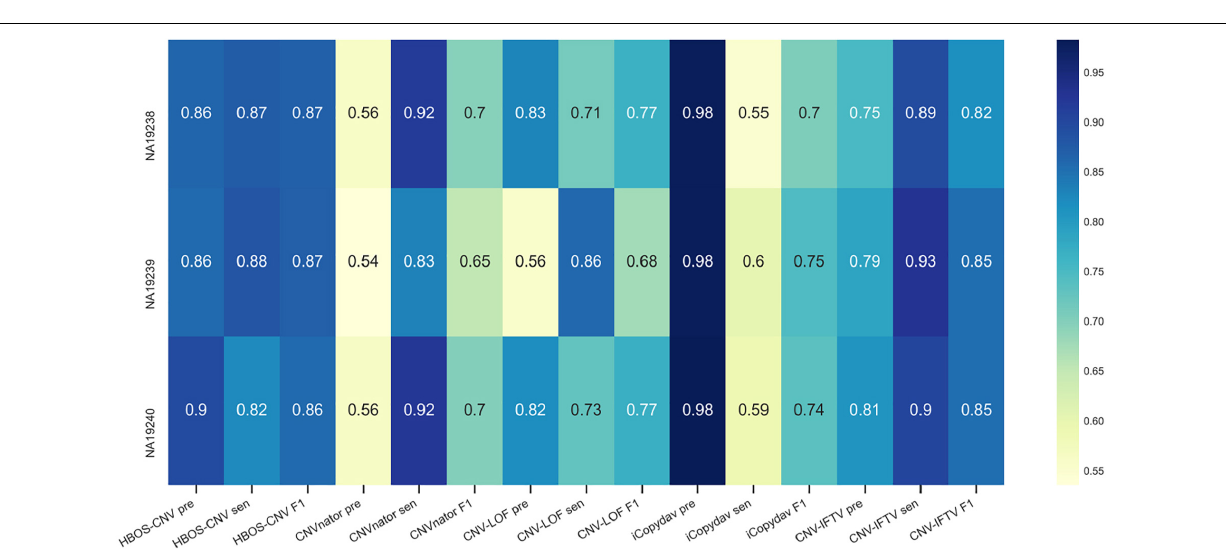
Frontiers in Genetics |